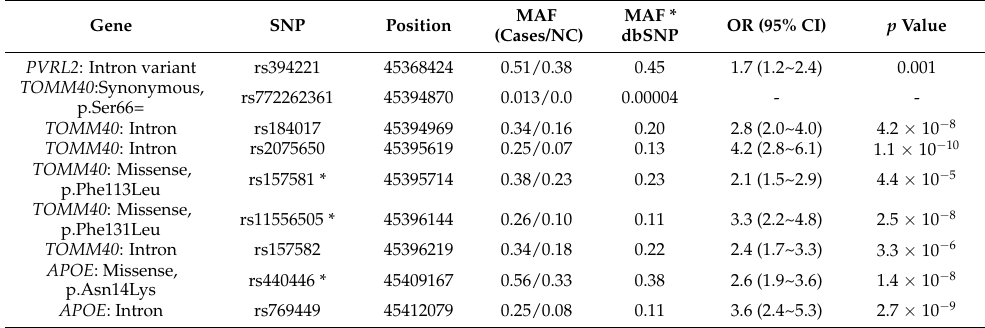
Table 1. Genetic variants within TOMM40-APOE region associated with risk of